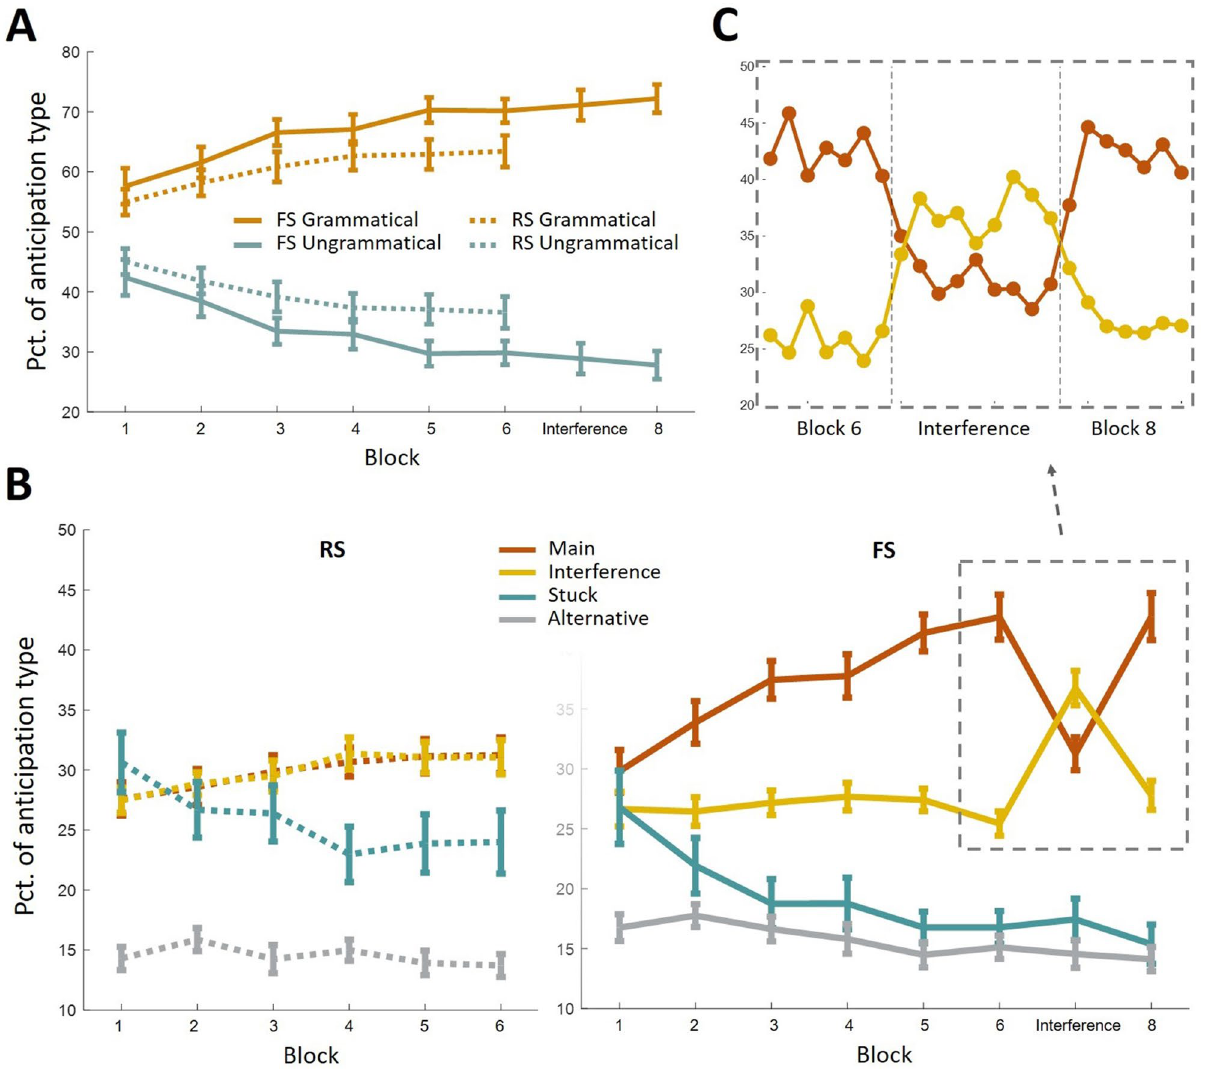
Figure 2. Distribution of anticipation types throughout the experiment. ( A ) Grammatical and ungrammatical fixations evolve similarly over practice in the FS and the RS groups and are not modulated by sequence interference. ( B ) ISI fixations are categorized into anticipation types according to the pair of stimuli that preceded them: Main is fixation at the location of the next target according to the sequence governing the task in blocks 1 to 6, Interference is at the next target location according to the sequence governing block 7, Stuck corresponds to fixation at the location of the last target, and Alternative at the location that is neither of the three. Anticipations of the RS group are given on the left panel in dotted lines and of the FS group on the right in solid lines. Error bars denote standard error of the mean. ( C ) Examining Main and Interference anticipations in sequence-by-sequence resolution uncovers quick modulation of behavior following a change in the underlying sequence in the FS